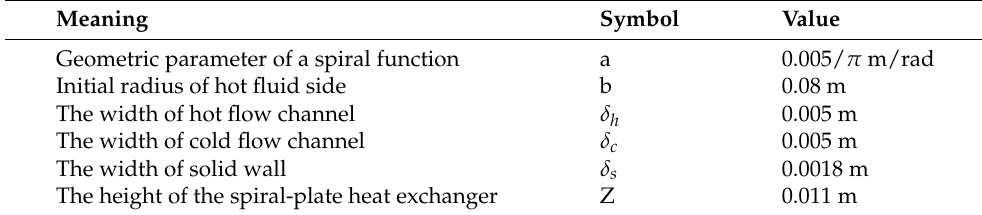
Table 1. Parameters of the spiral heat